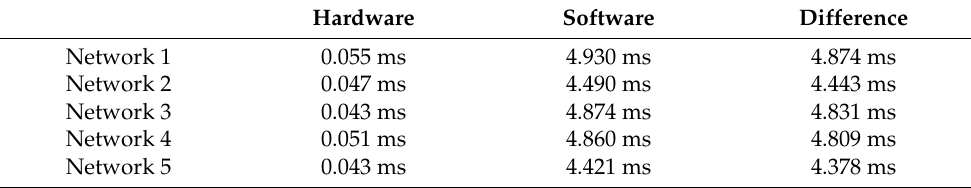
Table 6. Performance difference between hardware and software expert system networks. Table 7. Extra maneuverability caused by hardware implementation for different craft speeds for Network